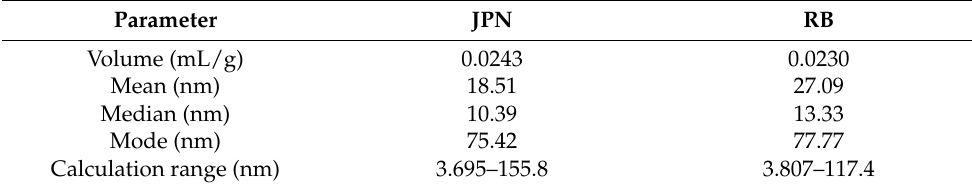
Table 3. Physical parameters of JPN and RB.